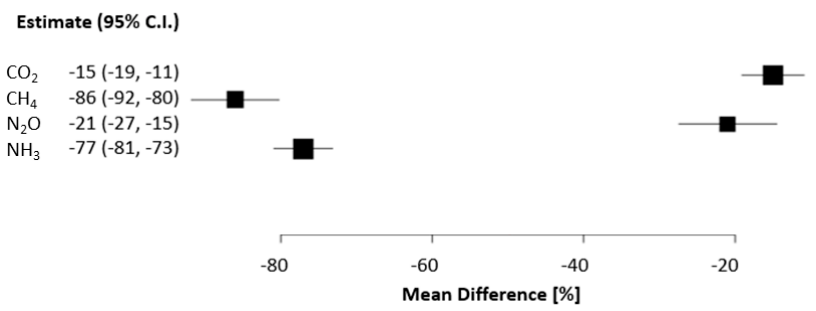
Figure 1. Forest plot of the impact of the acidification of animal slurry with reference to raw slurry. The black square boxes show the individual mean points of each gas. Horizontal bars indicate the 95% confidence intervals.